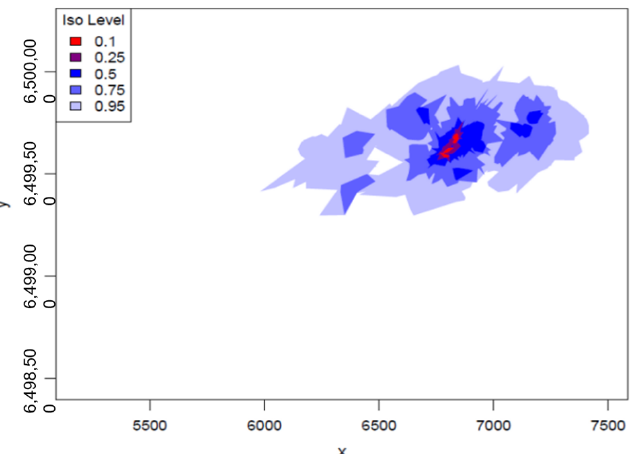
Figure 3. Isopleths constructed in different hulls sorted by area, indicating proportions of the total points enclosed by three focal sheep during the wet season.